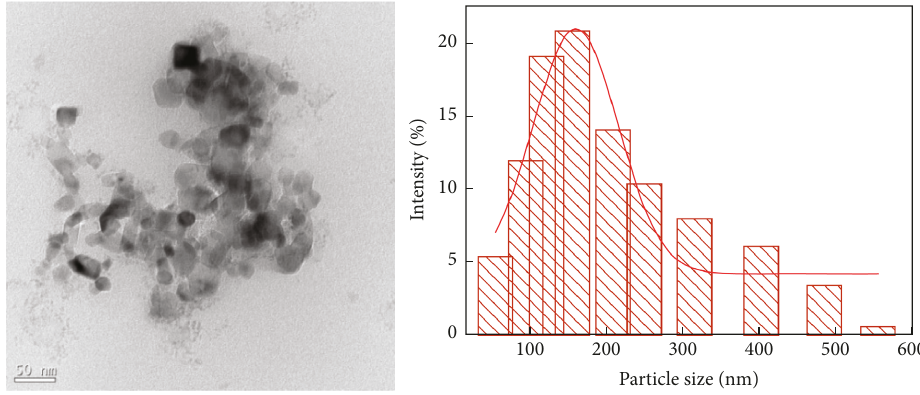
Figure 1: TEM micrograph and size distributions of SiO